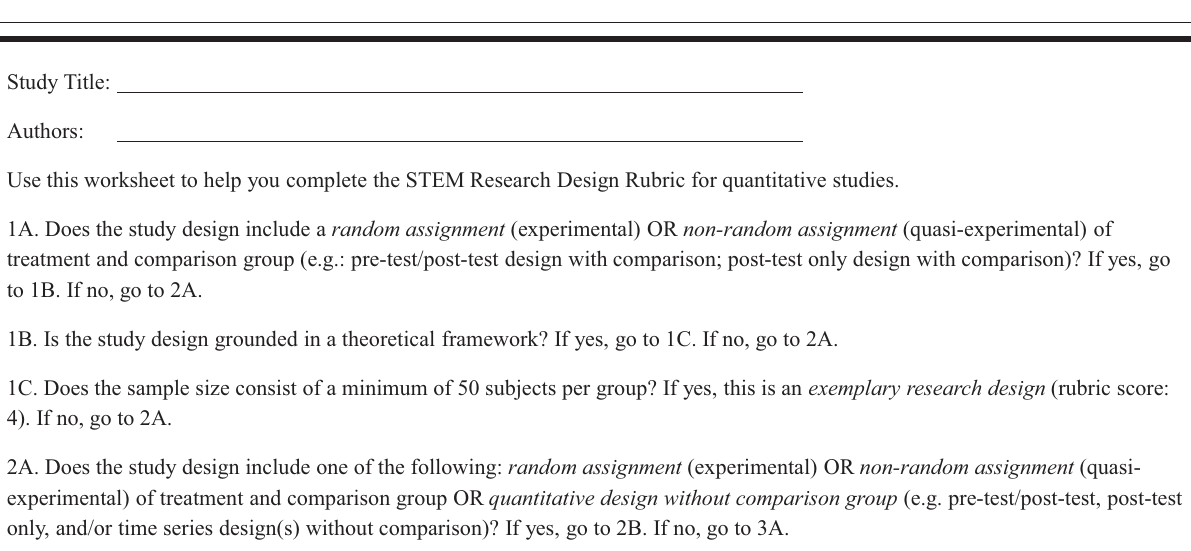
criteria indicative of high-quality STEM research and from focus group participants consisting of experienced ISE STEM researchers and